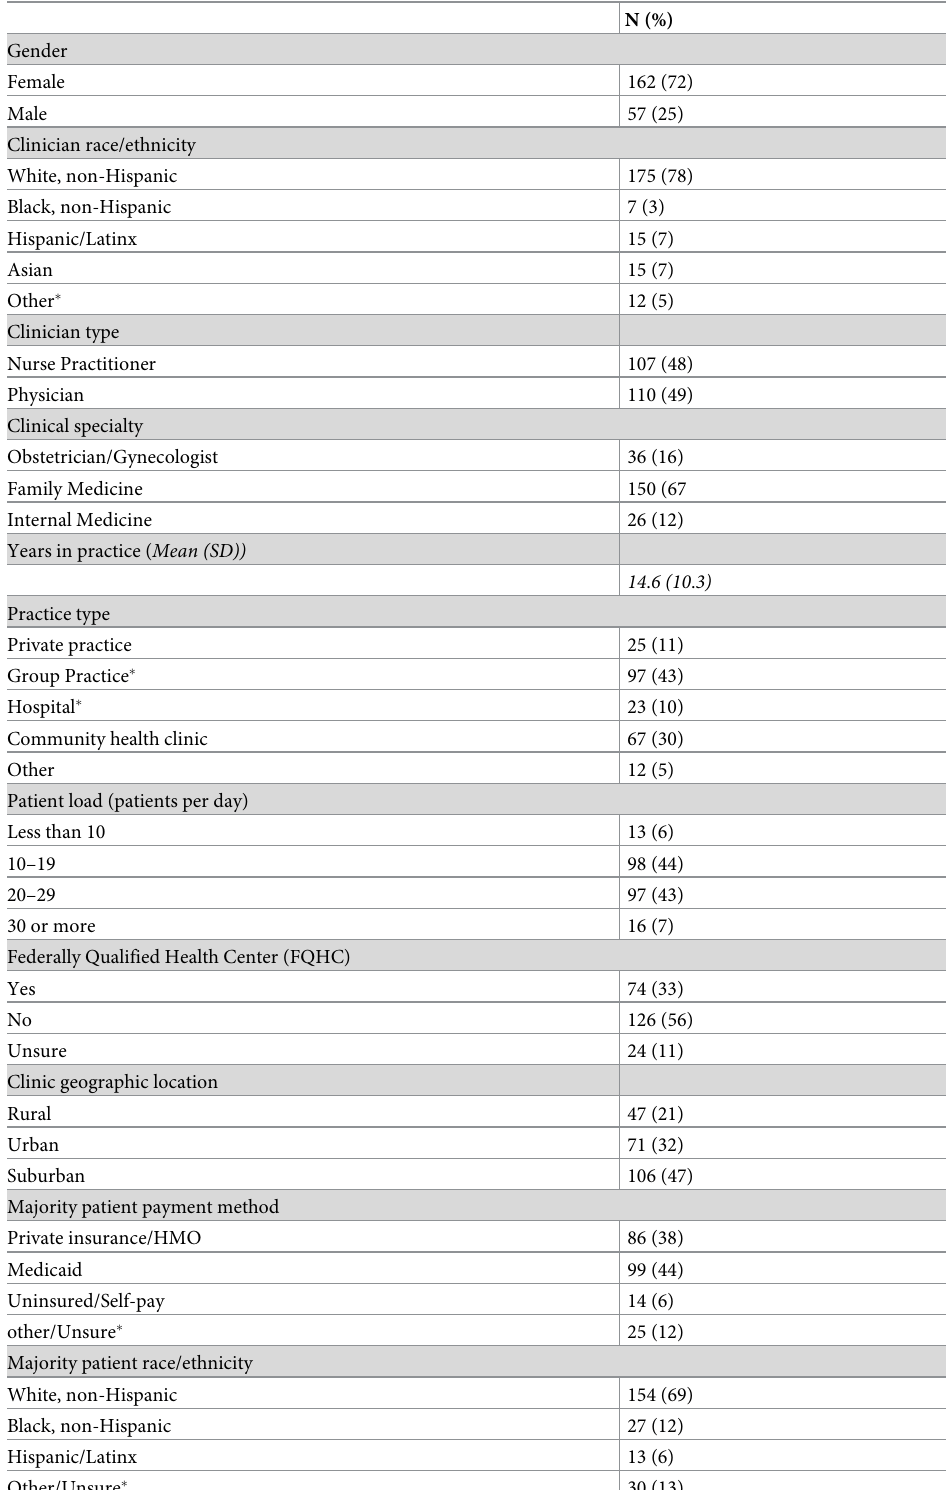
Table 1. Survey respondent demographics (n =